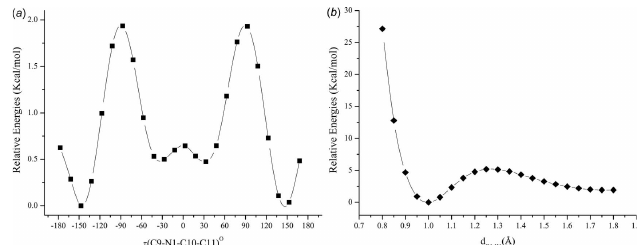
Figure 4 The potential energy curves for the torsional scan ( a ) and the O—H bond scan ( b ). Relative energies are calculated with respect to the global minimum of each